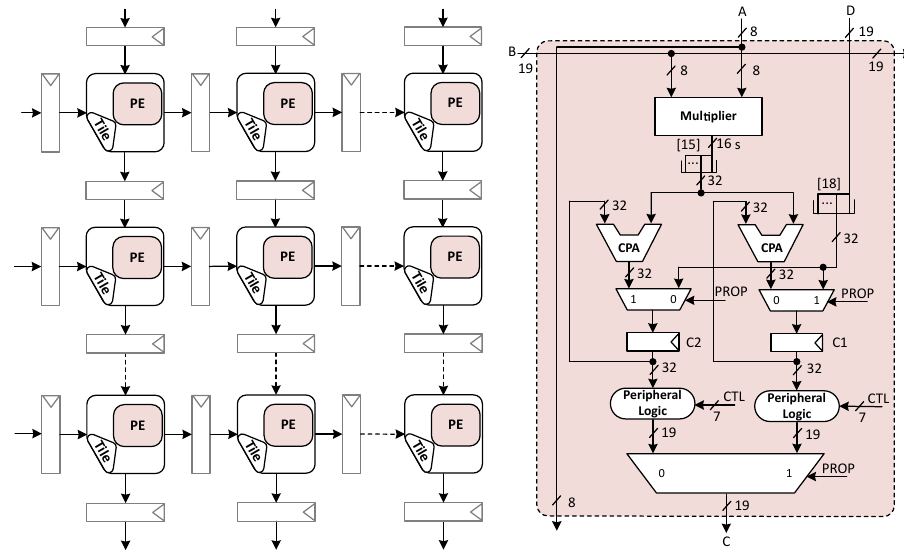
Figure 2. Gemmini systolic array architecture with output stationary